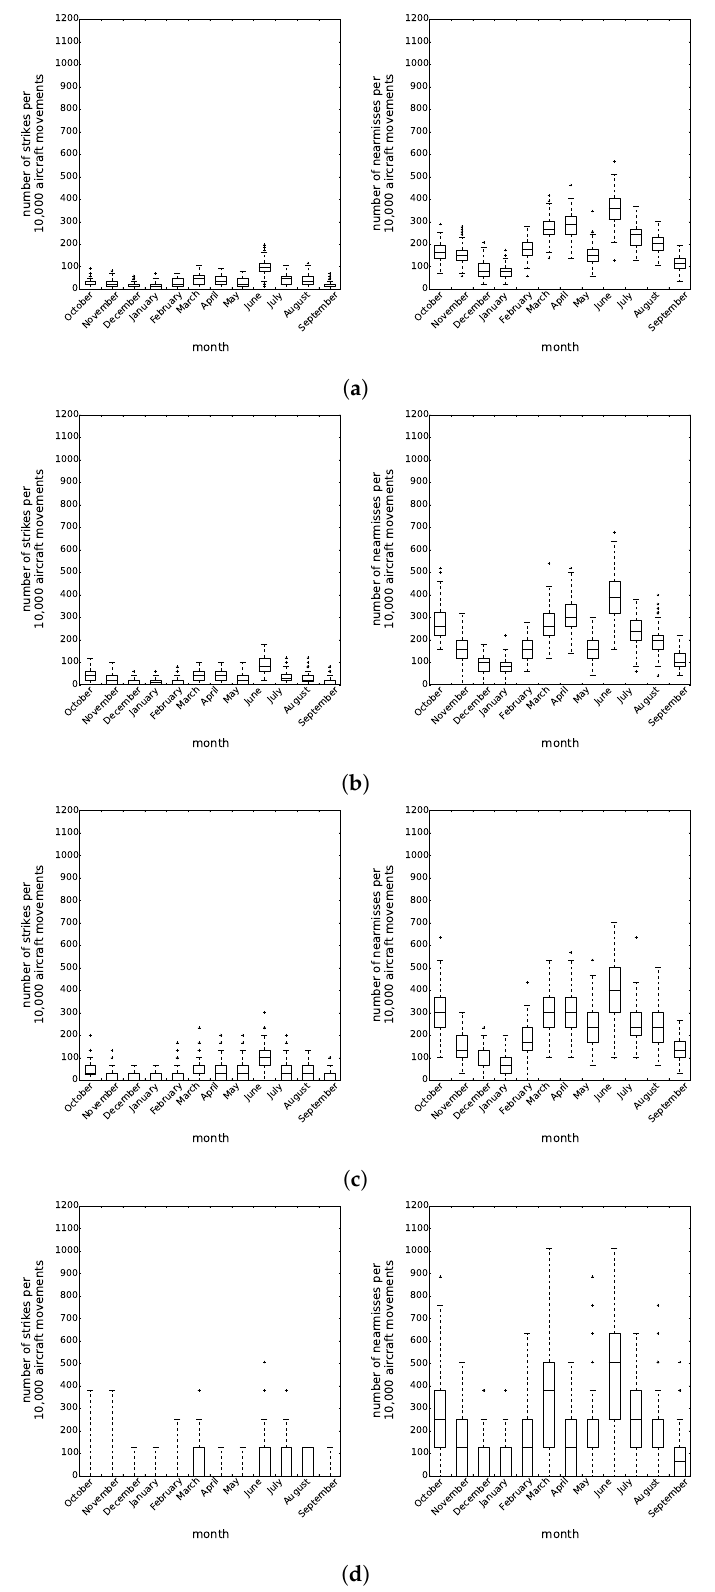
Figure 6. Boxplot values per month for the number of bird strikes over all Monte Carlo replications and for all traffic volumes. ( a ) Traffic scenario with high traffic density; ( b ) Traffic scenario with medium traffic density; ( c ) Traffic scenario with low traffic density; ( d ) Traffic scenario with very low traffic